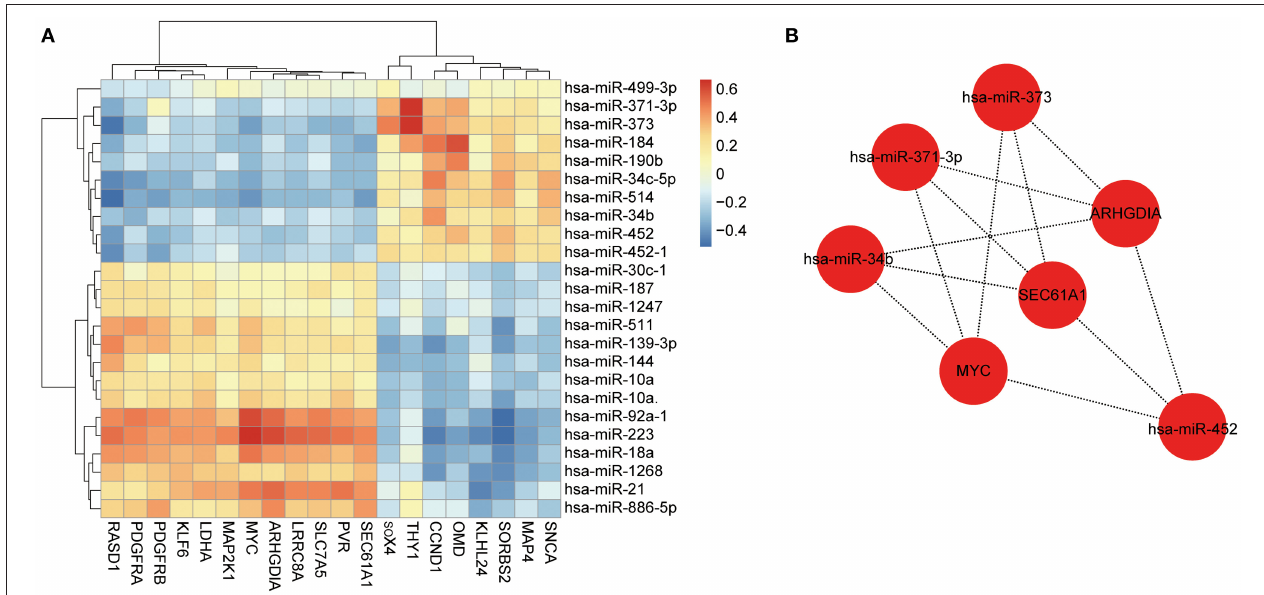
FIGURE 3 | Construction of miRNA-mRNA regulatory network. (A) Heatmap of correlation between miRNAs and mRNAs. Red represents positive correlation, and blue represents negative correlation. (B) Constructed miRNA-mRNA regulatory network with four miRNAs and three genes, basing on MNC